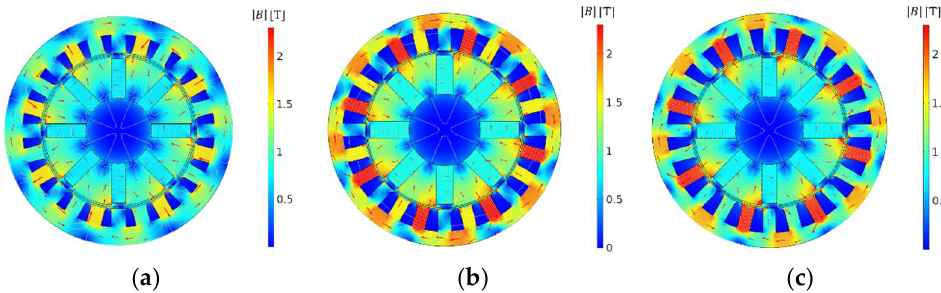
Figure 18. Distribution of magnetic flux distribution of selected geometries ( a ) F20, ( b ) V20, and ( c ) V30.